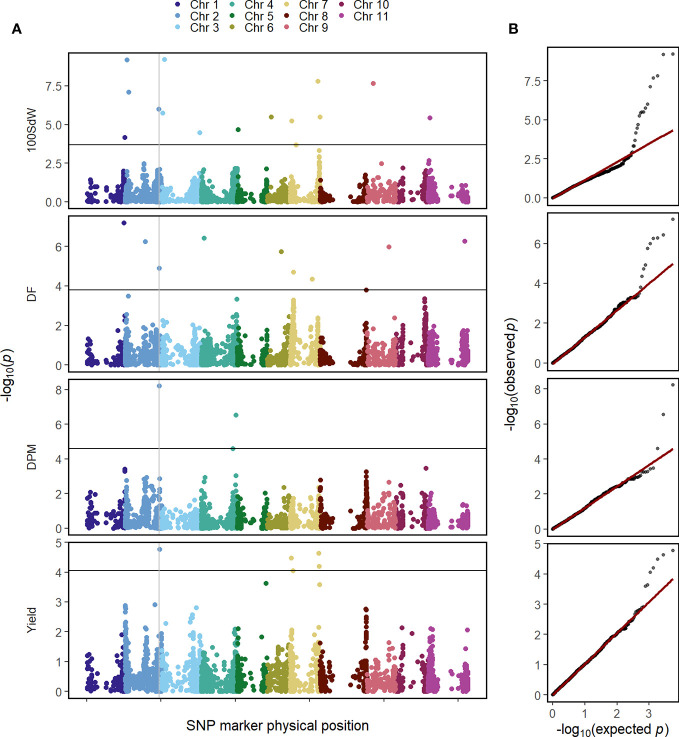
Genome-wide association study for in total 481 common bean lines using second-stage best linear unbiased estimators (BLUEs) across twelve trials for the traits 100 seed weight (100SdW), days to flowering (DF), days to physiological maturity (DPM), and seed yield. (A) The Manhattan plots show the significance of associations of every SNP marker for each trait calculated using the BLINK algorithm, implemented in GAPIT. The vertical line indicates a common QTL for DF, DPM and seed yield. The horizontal line shows the false discovery rate (p = 0.05) to identify significant associations. (B) Q–Q plots show the distribution of the negative logarithm of expected and observed p values.